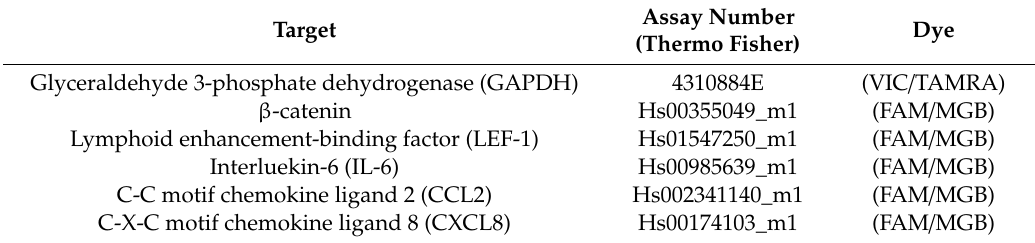
Table 1. Gene expression assay